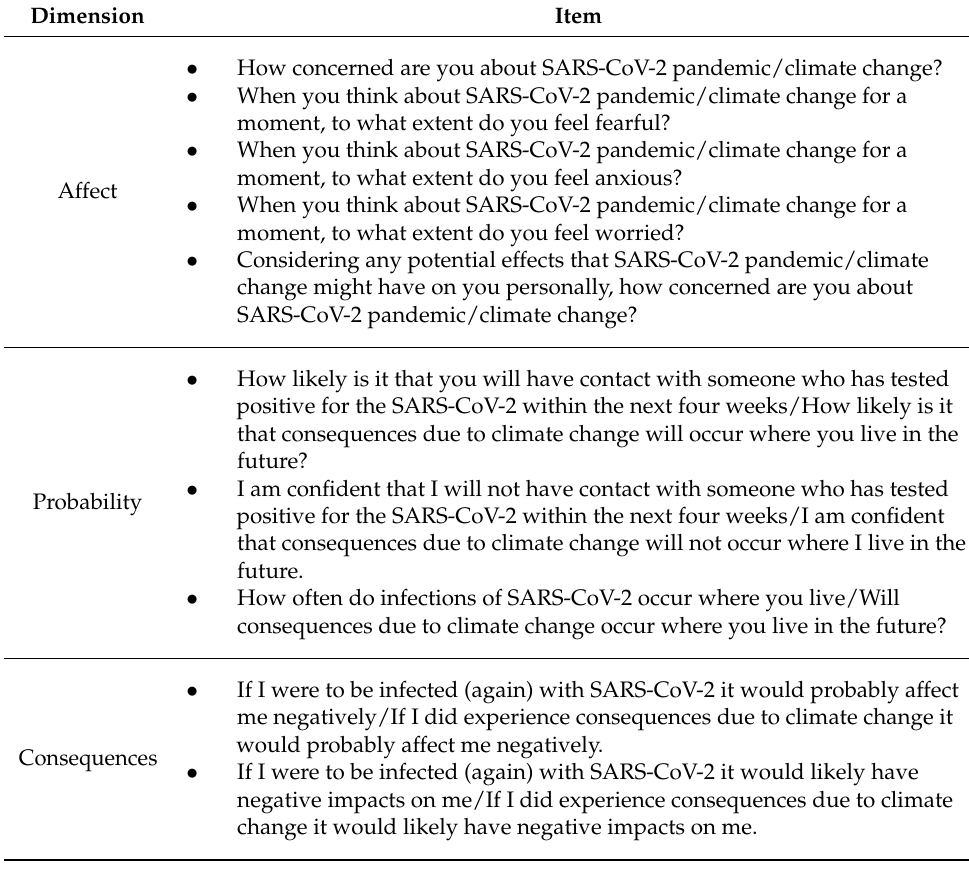
Table 1. Dimensions and related items of the risk perception scales for SARS-CoV-2 and climate change (based on Wilson et al. 2019